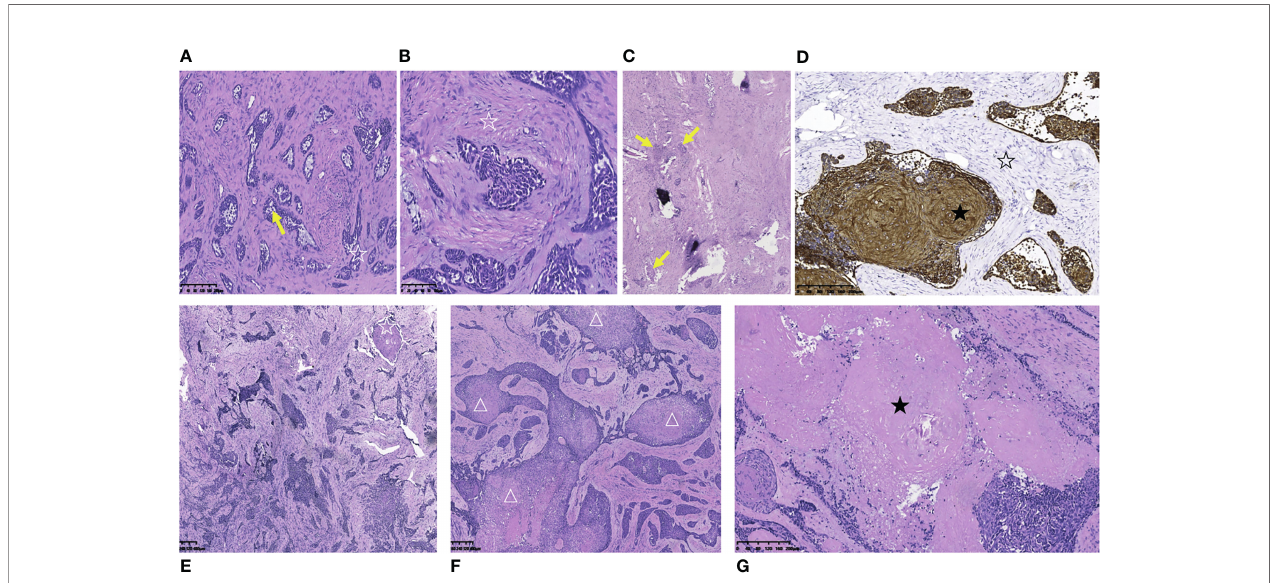
FIGURE 2 | Pathological and immunohistochemical pictures of metastatic thoracic adamantinoma in case 1. (A) Microscopically, the tumor tissue was composed of prominent epithelial cell islands and admixed with spindle-shaped fi brous stroma. The basaloid cells in the periphery of the epithelial island were arranged in a palisade pattern ( ☆ ), with star-shaped cells (yellow arrow) in the center (Scale 100 m ). (B) The fi brous stroma was composed of spindle-shaped fi broblasts ( ☆ ) with mild cellular atypia with local myxoid degeneration (Scale 100 m ). (C) Multifocal tumor cell nests (yellow arrow) in bone tissue and hyperplastic fi brous connective tissue (Scale 100 m ). (D) The tumor cells were diffusely strong positive for AE1/AE3 ( ★ ).The stromal cells were negative for AE1/AE3 ( ☆ ) (Scale 100 m ). (E) Microphotography of tumor resection specimen of T2 vertebral body in September 2019. Only a small amount of squamous differentiation could be seen ( ☆ ), without any necrotic area (Scale 100 m ). (F, G) Two months later (November 2019), a large amount of squamous differentiation ( △ ) and multifocal, large areas of necrosis ( ★ ) were seen in the resection specimen of the T7 vertebral body tumor (Scale 100 m